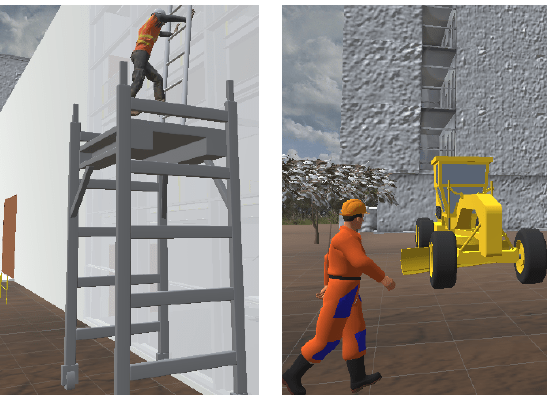
Figure 3. Left : An worker in a fall hazard situation. Right : An worker in a struck-by hazard